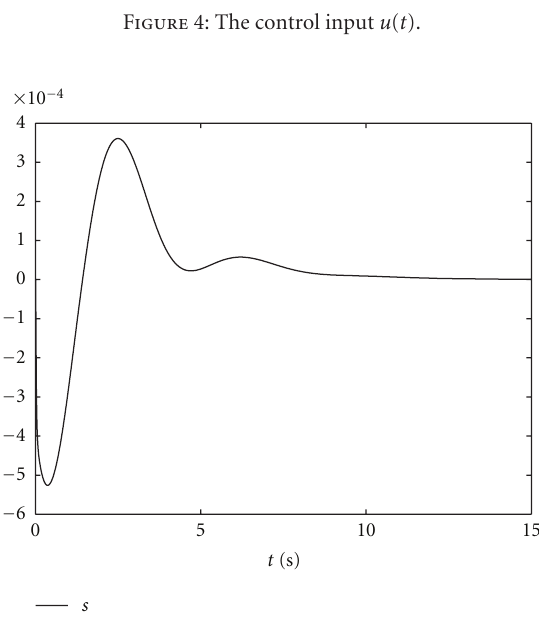
Figure 4: The control input u ( t ).